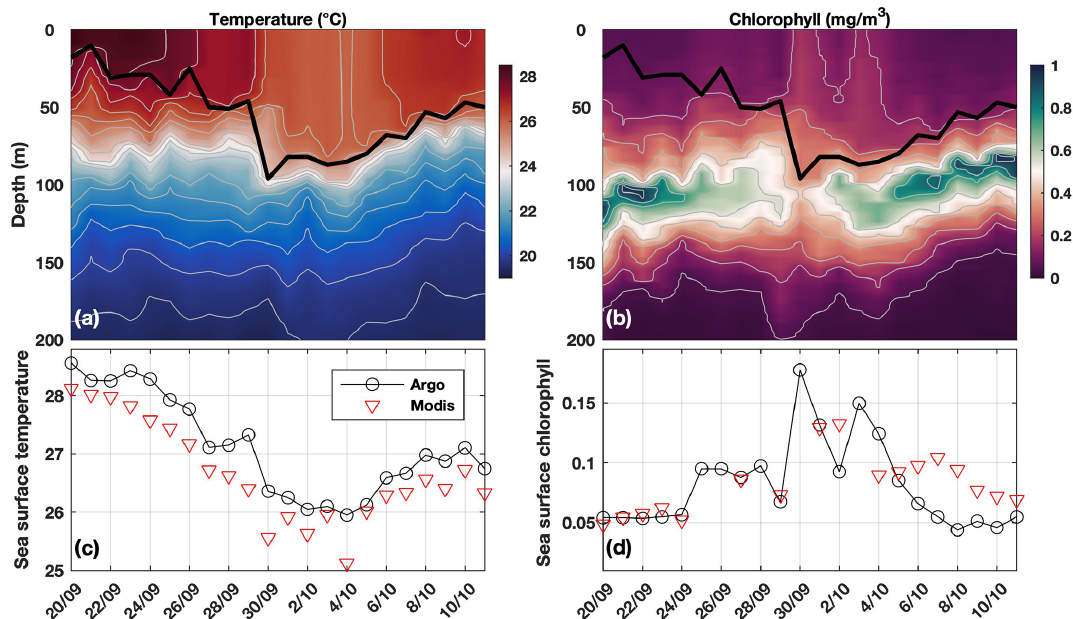
Figure 2. Sections of temperature (a) and chlorophyll (b) captured by the BGC-Argo; superimposed as the thick black curve is the mixed- layer depth (MLD). Comparison between the sea surface temperature (c) and chlorophyll (d) from the BGC-Argo and remote sensing observations. Typhoon Trami passed nearby BGC-Argo on 30 September